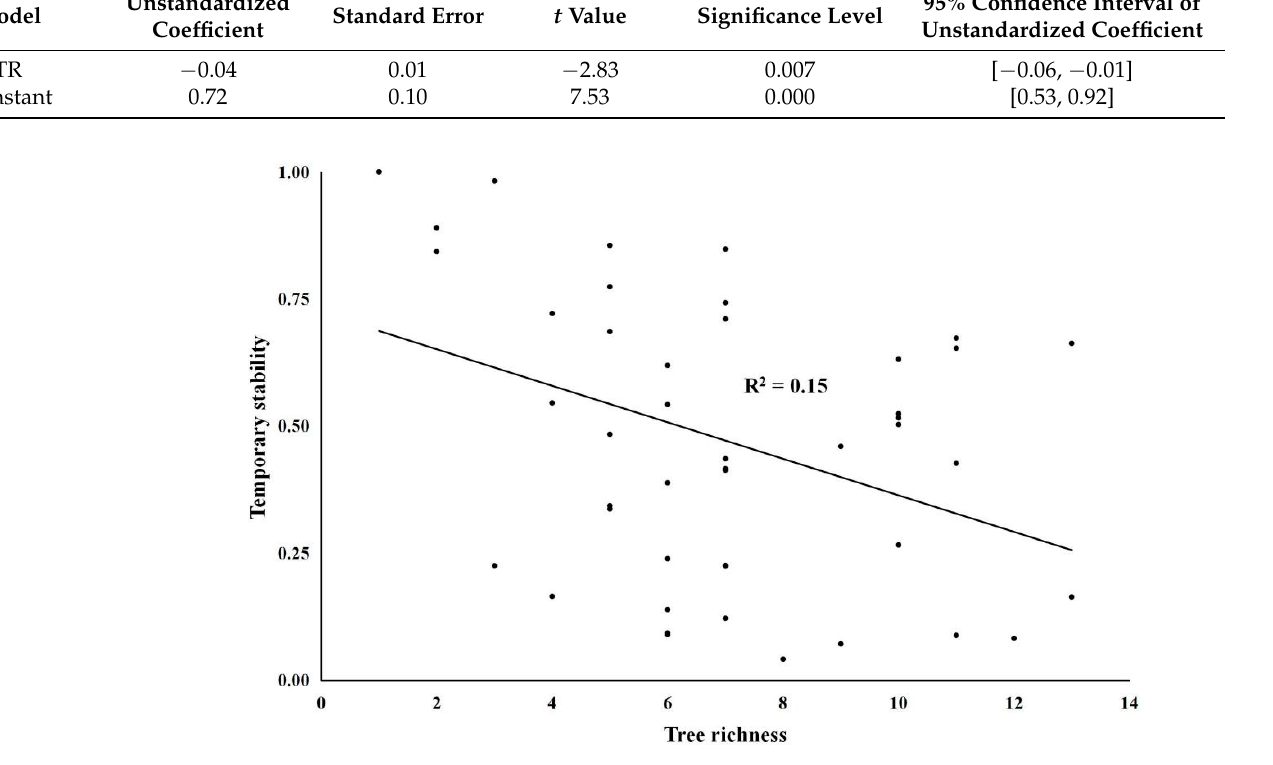
Figure 2. Scatter diagram between temporary stability (TS) and tree richness (TR).